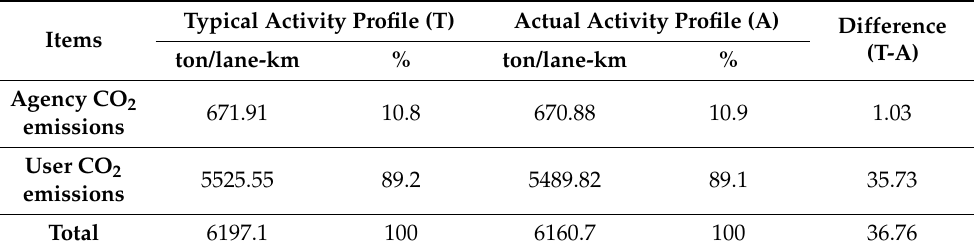
Table 2. The total CO 2 emissions in the two activity profiles